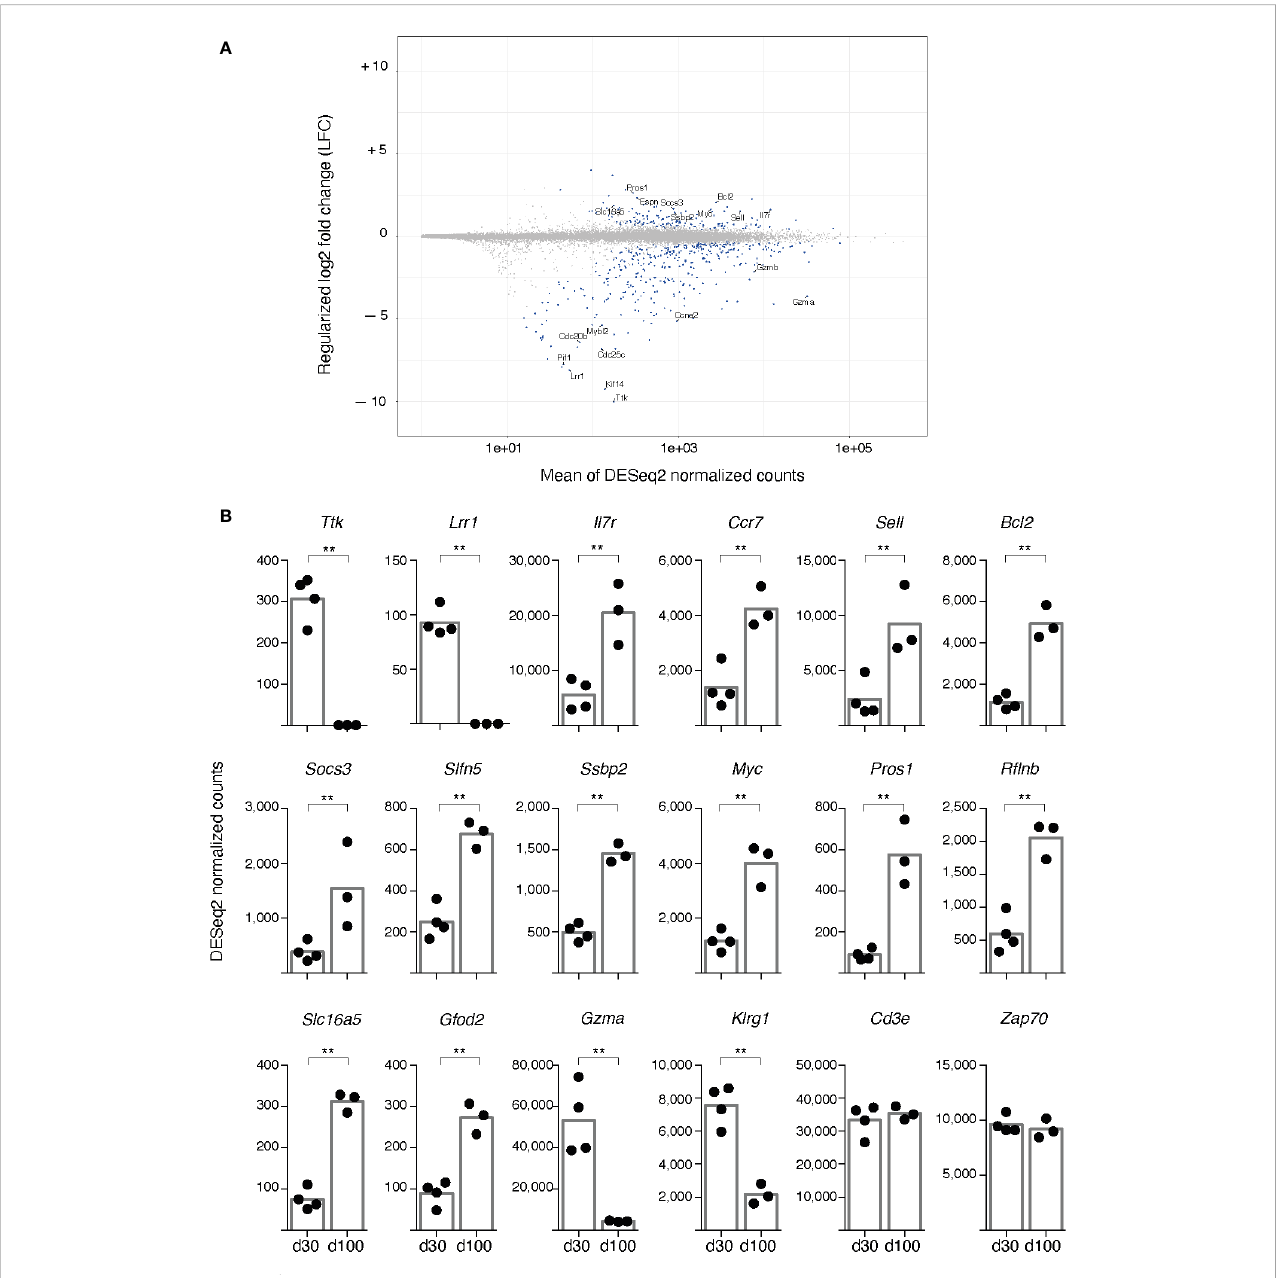
FIGURE 4 RNA seq analysis of spleen gag-speci fi c CD8 T cells at d30 and d100 post-prime. Bulk RNA was sequenced from sorted spleen gag-speci fi c CD8 T cells at d30 and d100 post-prime, in 4 independent prime experiments with a total of 7 samples. Bioinformatic analysis was performed to compare d100 and d30. (A) . Scatterplot of genes whose estimated absolute log-2 fold change was < 11. The y-axis represents Log-2 fold changes regularised using an empirical Bayes method, and the x-axis represents means across all samples of the DESeq2-normalised counts. Differentially expressed genes (DEGs) with a statistically signi fi cant difference (false discovery rate (FDR) ≤ 0.01) are highlighted in blue. Selected gene symbols among the top 50 signi fi cantly upregulated (top 50-up) and the top 50 signi fi cantly downregulated (top 50-down) genes are indicated (see Figure S4 for full list). (B) . DESeq2- normalised counts of representative DEGs having a statistically signi fi cant difference between d100 and d30, i.e. Ttk, Lrr1, IL7r, Ccr7, Sell, Bcl2, Socs3, Slfn5, Ssbp2, Myc, Pros1, R fl nb, Slc16a5, Gfod2, Gzma, Klrg1. Analysis of Cd3e and Zap70 is included. Each symbol represents an individual sample; columns represent the mean of d30 and d100 group; statistically signi fi cant differences are indicated (** FDR ≤